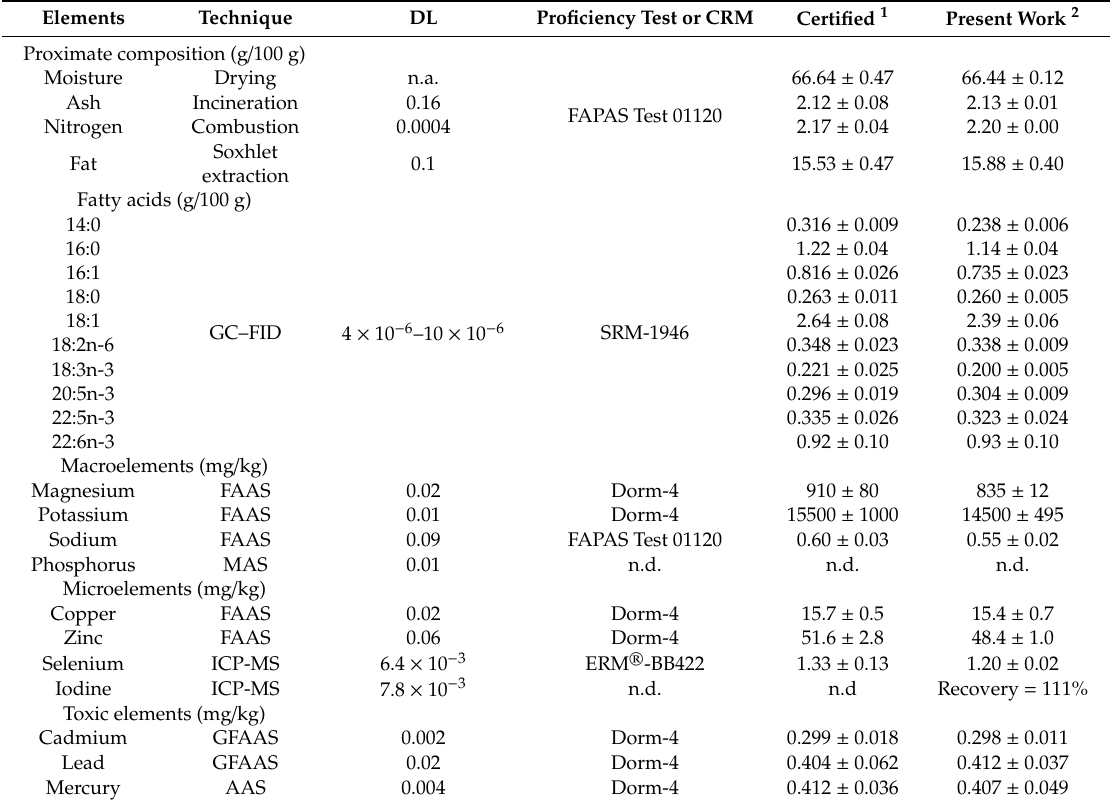
Table 1. Quality assurance of the proximate composition, fatty acids and macro, micro, and toxic elements analyses ( n =